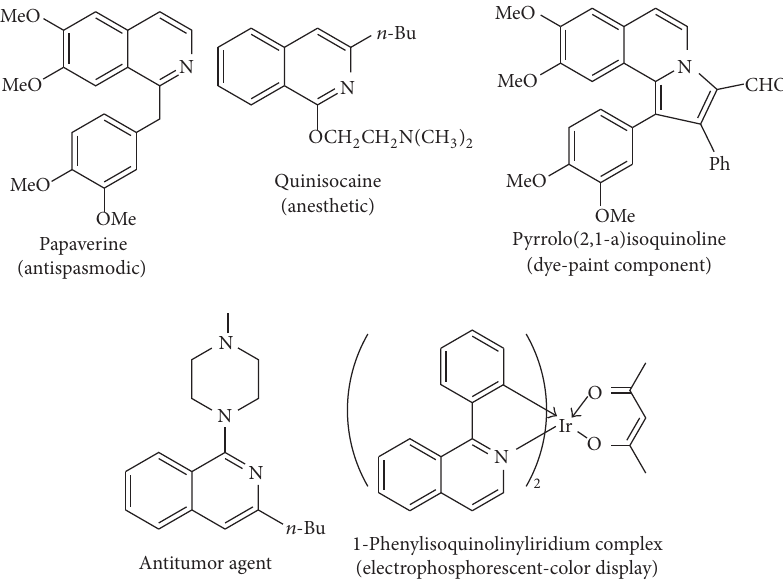
Figure 2: Selected medicinal, agricultural, and industrial isoquinoline derivatives.